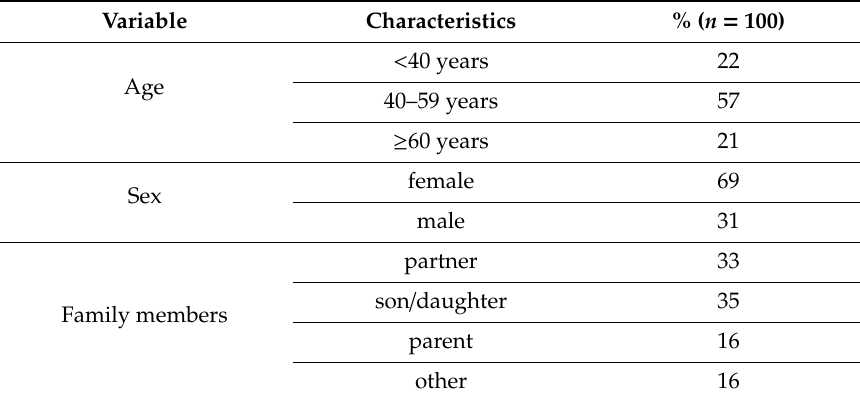
Table 1. Characteristics of the interviewees.